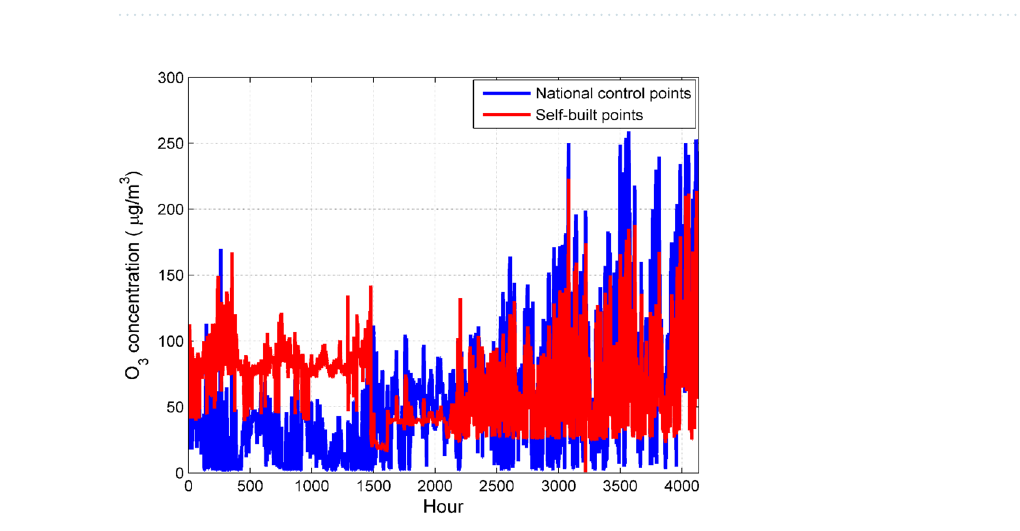
Table 1. Descriptive statistics of pollutant concentrations and meteorological parameters measured by national control points and self-built points after pretreatment.